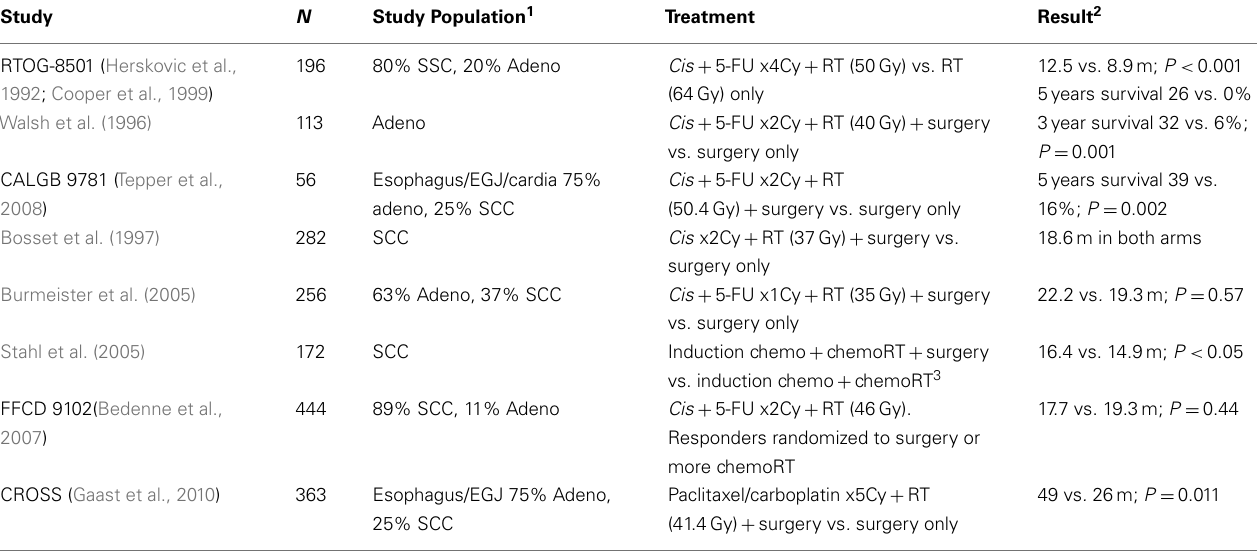
Table 2 | Phase III studies using neo-adjuvant chemoradiation